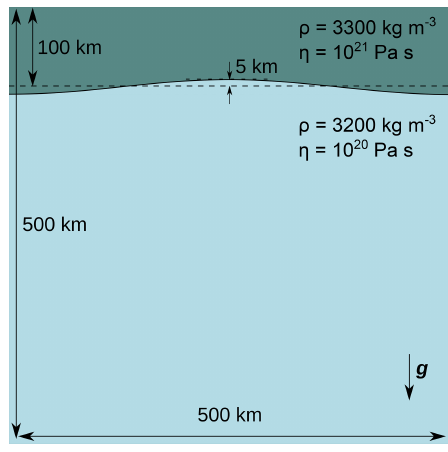
Figure E1. Sloshing free surface benchmark initial setup.